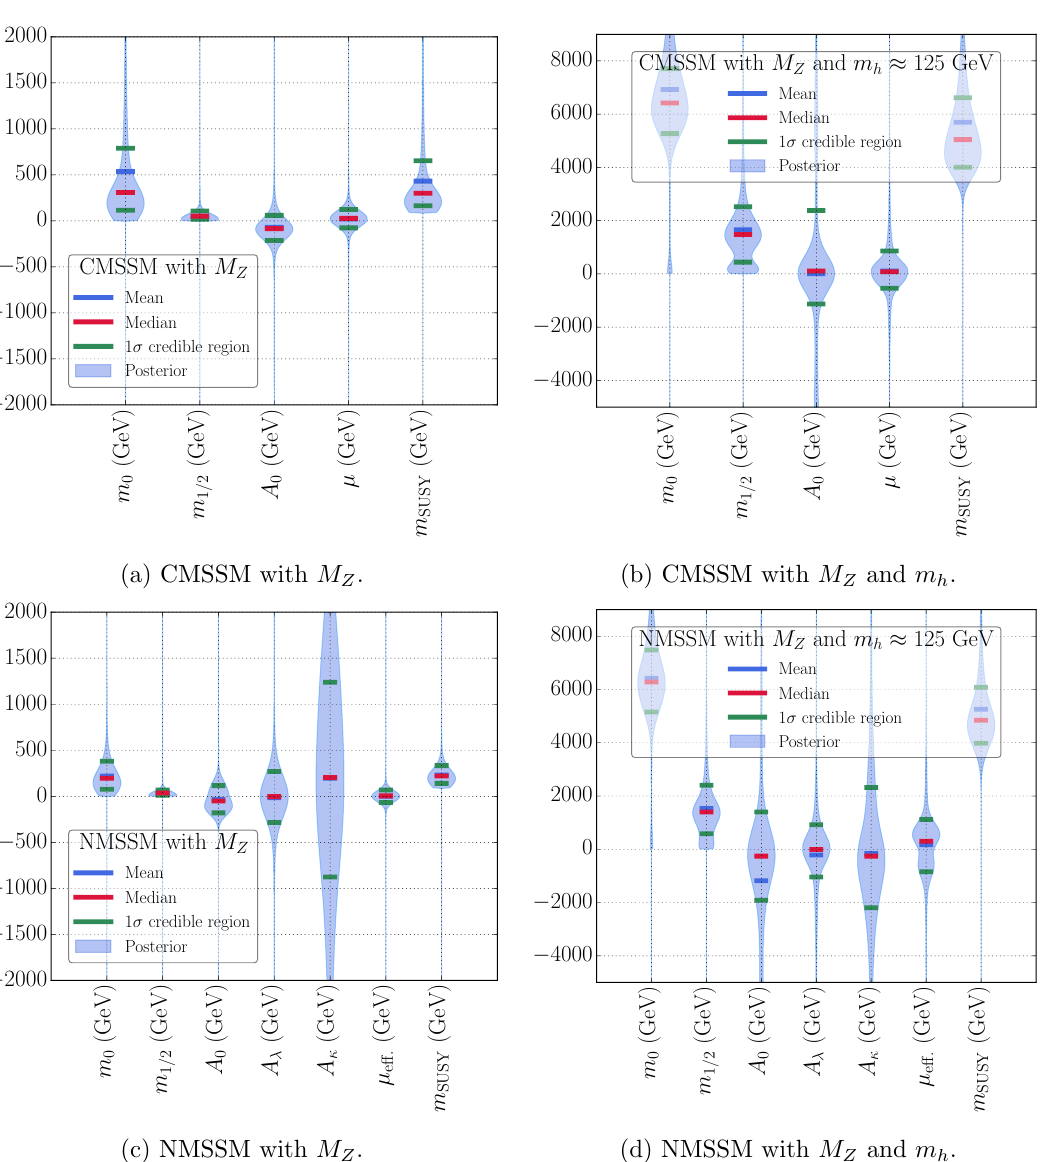
Figure 11. Violin plots showing one-dimensional posterior and summary statistics for important dimensionful parameters in the CMSSM (upper) and NMSSM (lower) with only M Z (left) and M Z and m h (right) in the